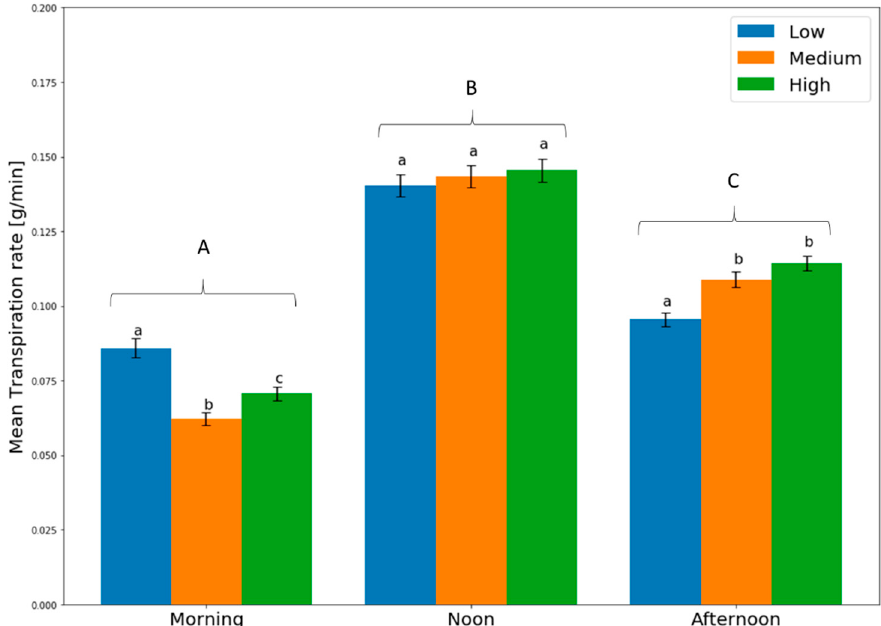
Figure 7. Mean ± SE transpiration rates by the daytime (significant differences are marked with different uppercase letters, A,B,C) and the different treatment groups (high, medium and low levels of potassium fertilization, significant differences are marked with different lowercase letters, a,b,c). Groups were compared using the Friedman test followed by the Wilcoxon signed rank test. Different letters above bars represent significant differences.